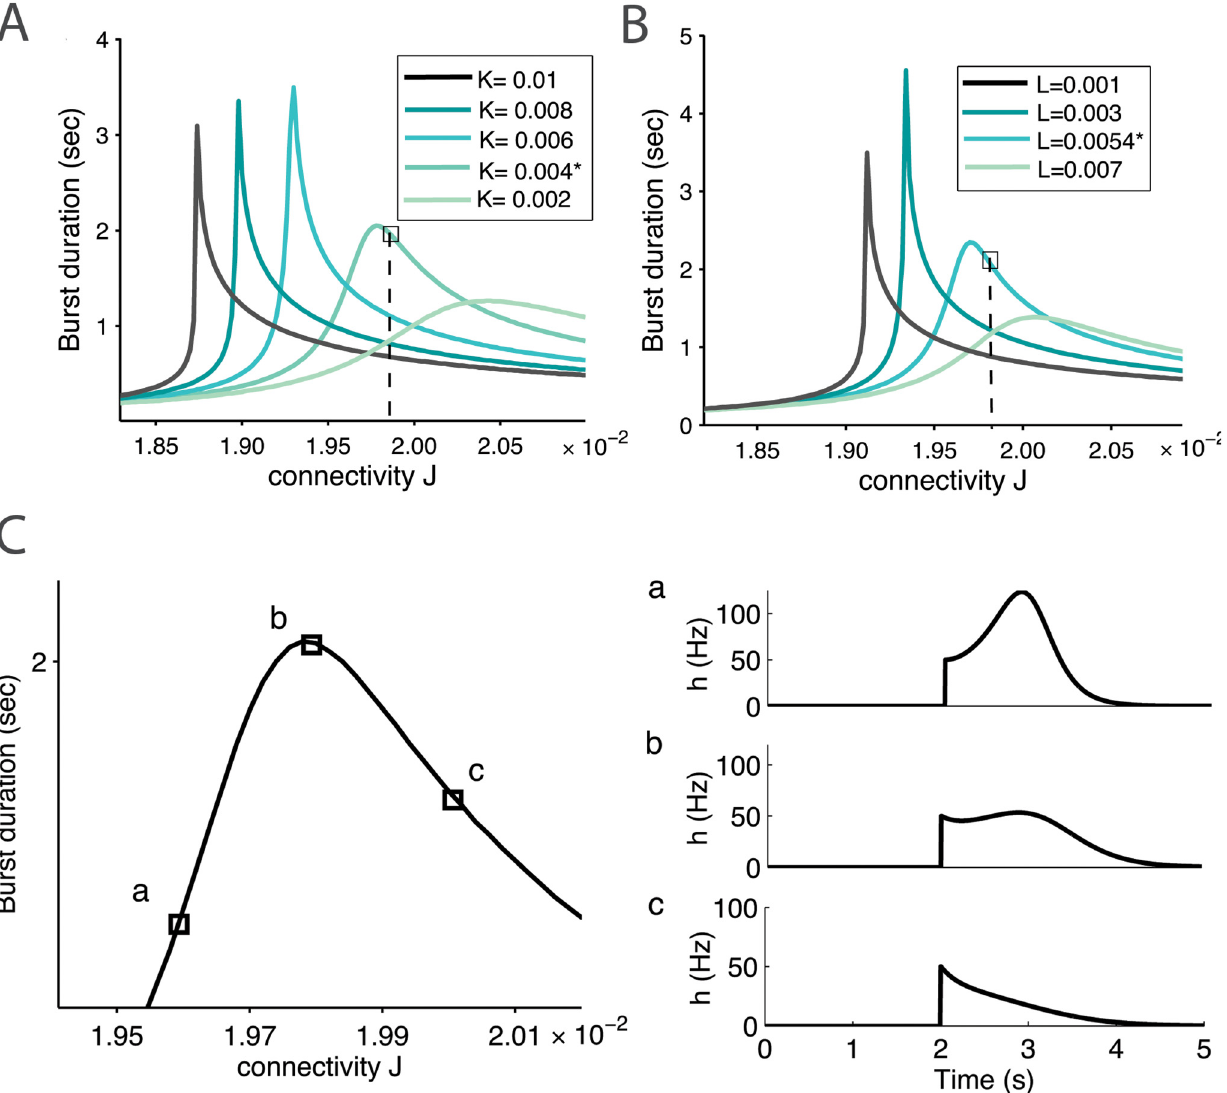
Fig 3. Reverberation time as a function of synaptic connectivity. (A) Burst duration time as function of the network connectivity (parameter J ) for different values of the facilitation parameter K and (B) the depression parameter L , (other parameters are described in Table 1). We indicate the position of variable extracted for the experimental datas, which lie close to the maximum. (C) Burst shapes at three different stages of the bell shape curve (parameter L * and K * ).